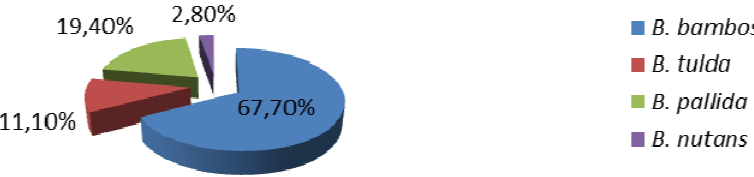
Fig. 1. Pie chart showing the distribution of AM